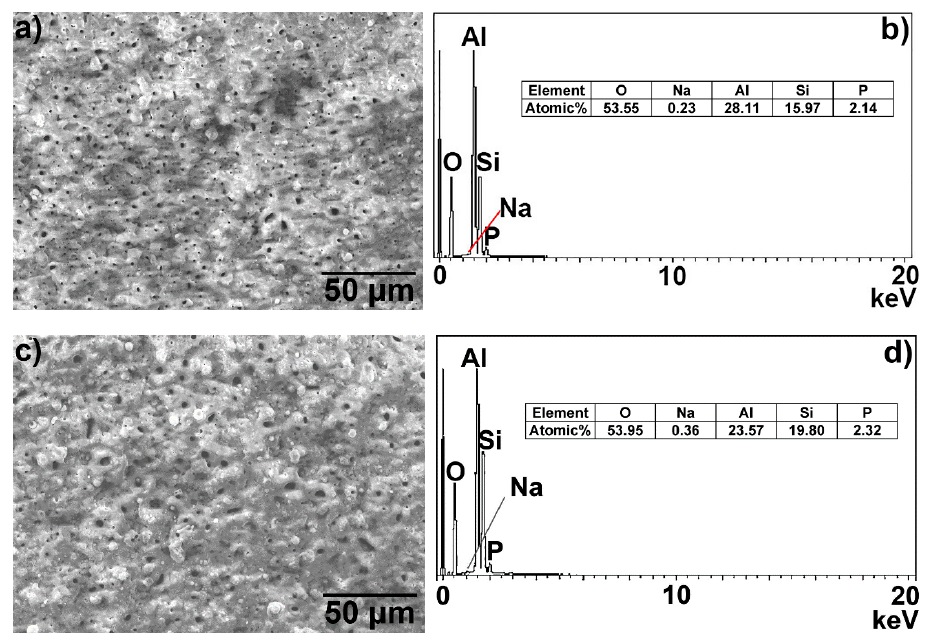
Figure 5. Surface morphology and composition of the MAO ceramic layer of the hot-dip aluminised coating on the TA2 substrate: ( a ) and ( b ) T ‐ 1 and ( c ) and ( d ) T ‐ 2 samples, respectively.